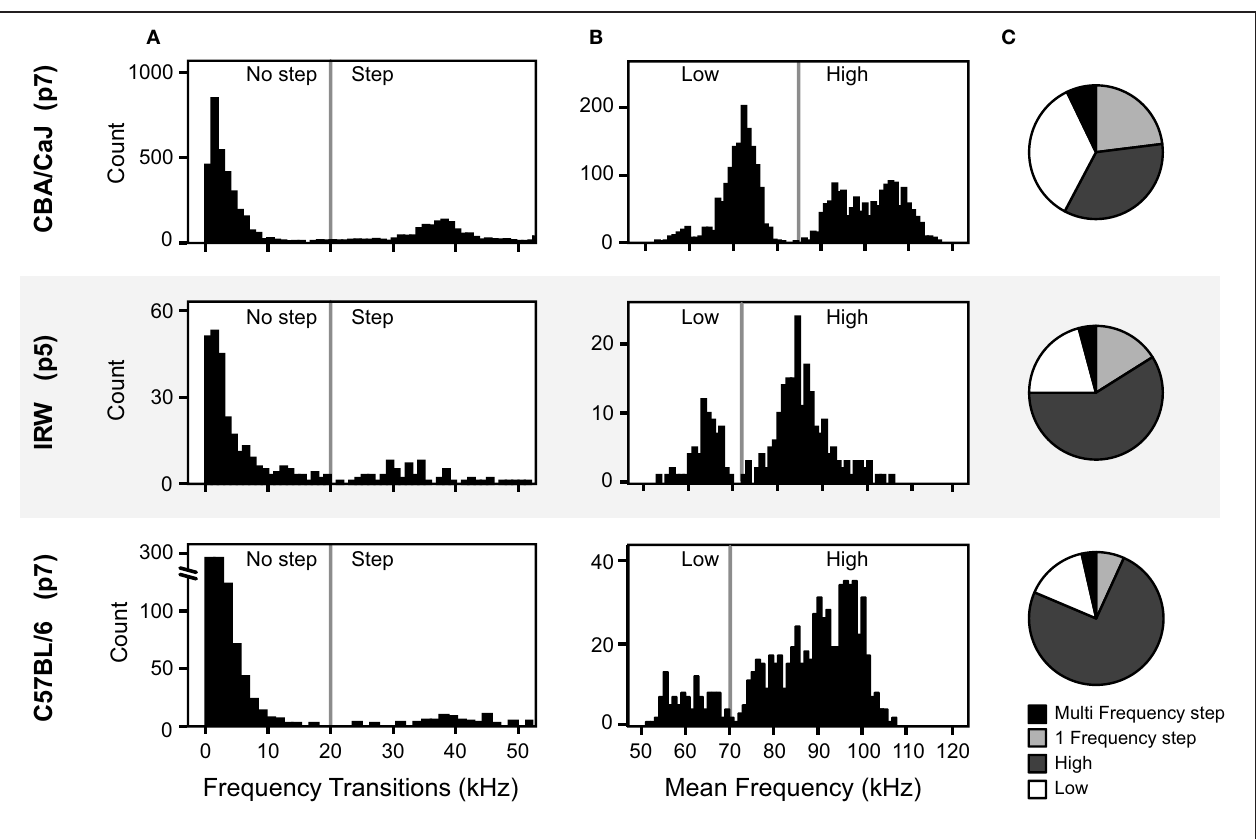
FIGURE 10 | Comparison of acoustic features of pup vocalizations in three mouse strains. (A) Distributions of the frequency transitions. The vertical lines at 20kHz marks the criterion for a frequency step across the three strains. (B) Distributions of the average frequency of syllables without